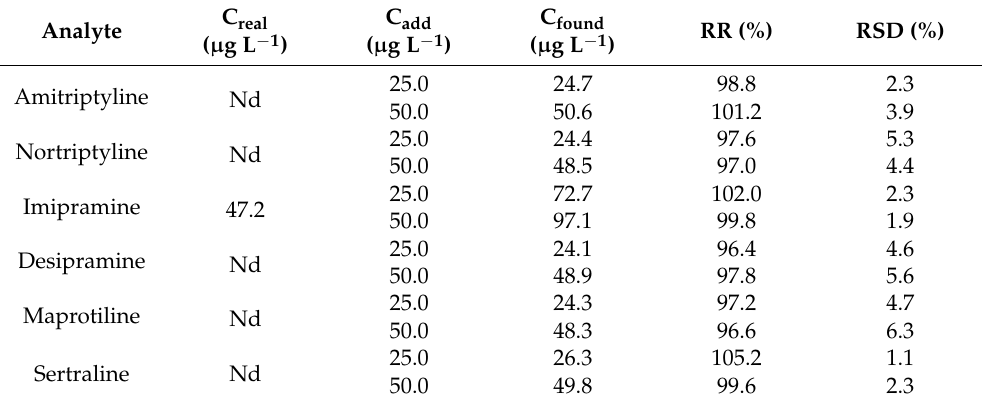
Table 4. Obtained results from the determination of TCAs in the urine sample taken 2 h after consumption of imipramine spiked at two different concentration levels.